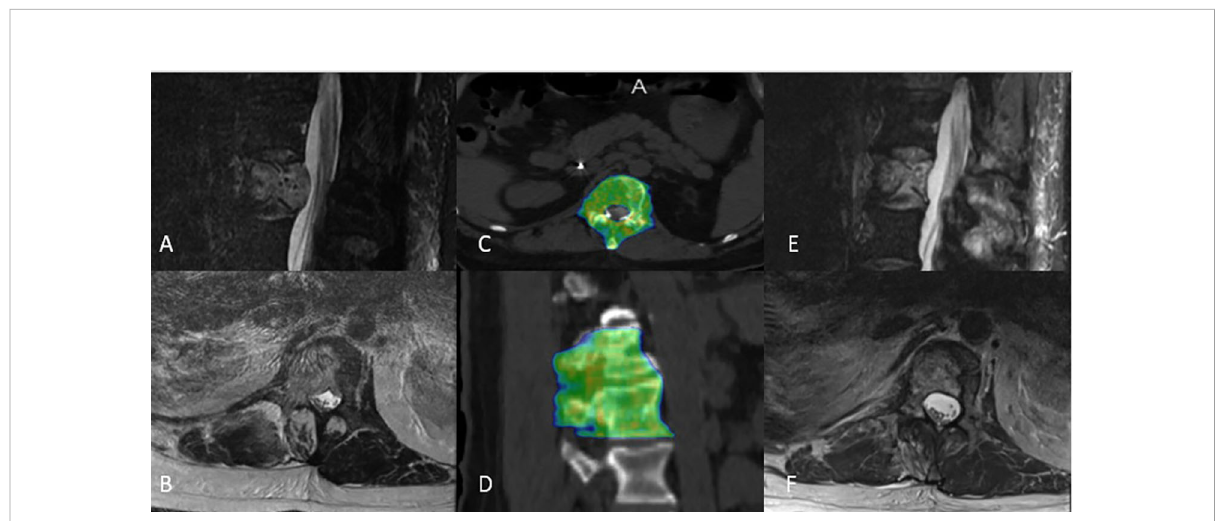
FIGURE 4 Representative circumferential stereotactic body radiation therapy plan from a patient treated to T12-L1 with (A, B) T2-weighted sagittal and axial MRI showing spinal canal narrowing due to extensive metastatic disease involving the vertebral body, right lateral compartment, and posterior compartment. (C, D) He was treated to 27 Gy in three fractions. (E, F) Surveillance T2-weighted sagittal and axial MRI showed with disease regression 4 months